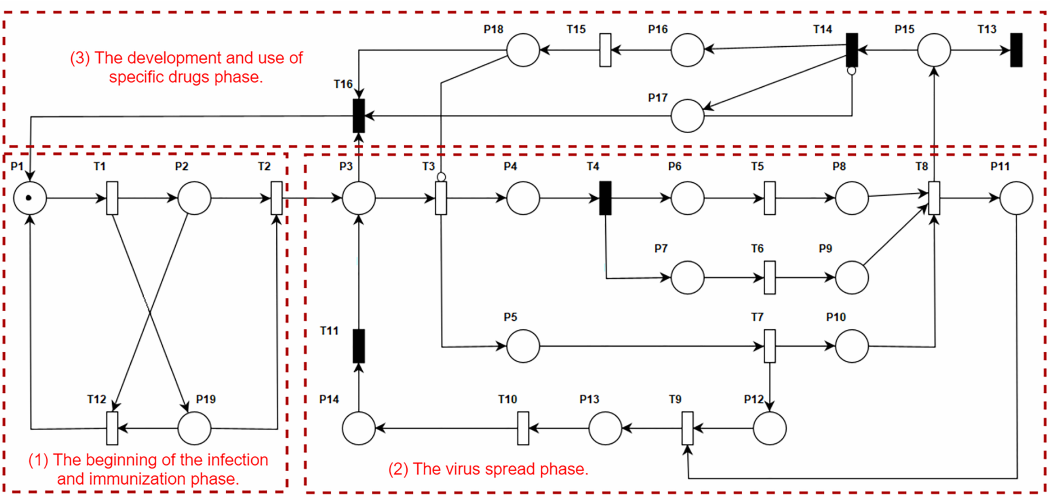
Figure 3. The GSPN model of the transmission of infectious diseases. (1) The beginning of the infection and immunization phase. This phase is the process of infection and immunity. P1 is the beginning of the virus spread. T1 represents that the virus starts to infect intermediate hosts. P19 represents the susceptible population. T12 is a timed and key transition that represents whether the vaccine is successfully developed and vaccinated. If all of susceptible people have been vaccinated, the virus will not be able to spread. The token will return to the place of P1. However, if the susceptible people have no vaccine, the virus will start to infect people from intermediate hosts. T2 stands for the virus from intermediate hosts to the people. Because the development of the vaccine needs a relatively long time, the virus will infect people from intermediate hosts. The model will go to the next phase. (2) The virus spread phase. This phase is the process of the virus spread. P3 represents the infected people. T3 is a timed and key transition that depicts whether the infected people have symptoms. P4 stands for people with symptoms after infection. P5 stands for people with mild or no symptoms after